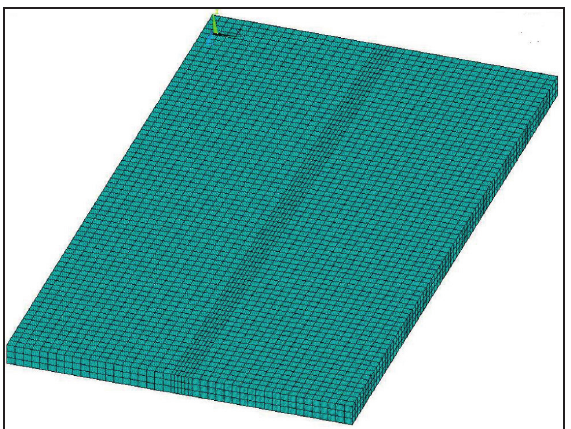
Figure 3: Meshing of the